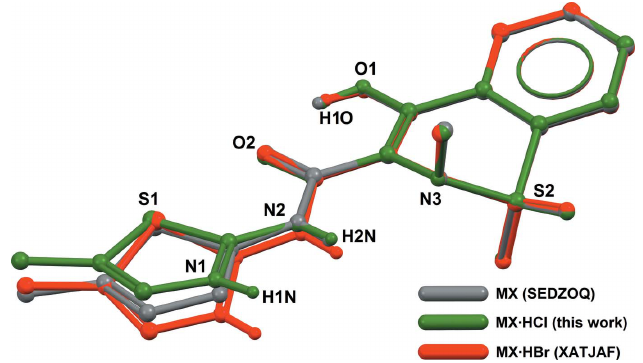
Figure 3 Overlay between meloxicam (grey), MX (cid:2) HBr (red) and MX (cid:2) HCl (green), calculated with Mercury (Macrae et al. , 2020). The fits were carried out using atoms belonging to the 1,2-benzothiazine core (14 atoms), while the amide and thiazole groups were kept free. The r.m.s. deviations for the fits are better than 0.04 A˚ . For the structure of the neutral molecule MX, which has been reported three times, refcode SEDZOQ was retained (Fabiola et al. , 1998), in order to have all models at room temperature. For clarity, halide anions are omitted, as well as H atoms bonded to C atoms. Note that in MX, the thiazole ring is not protonated.